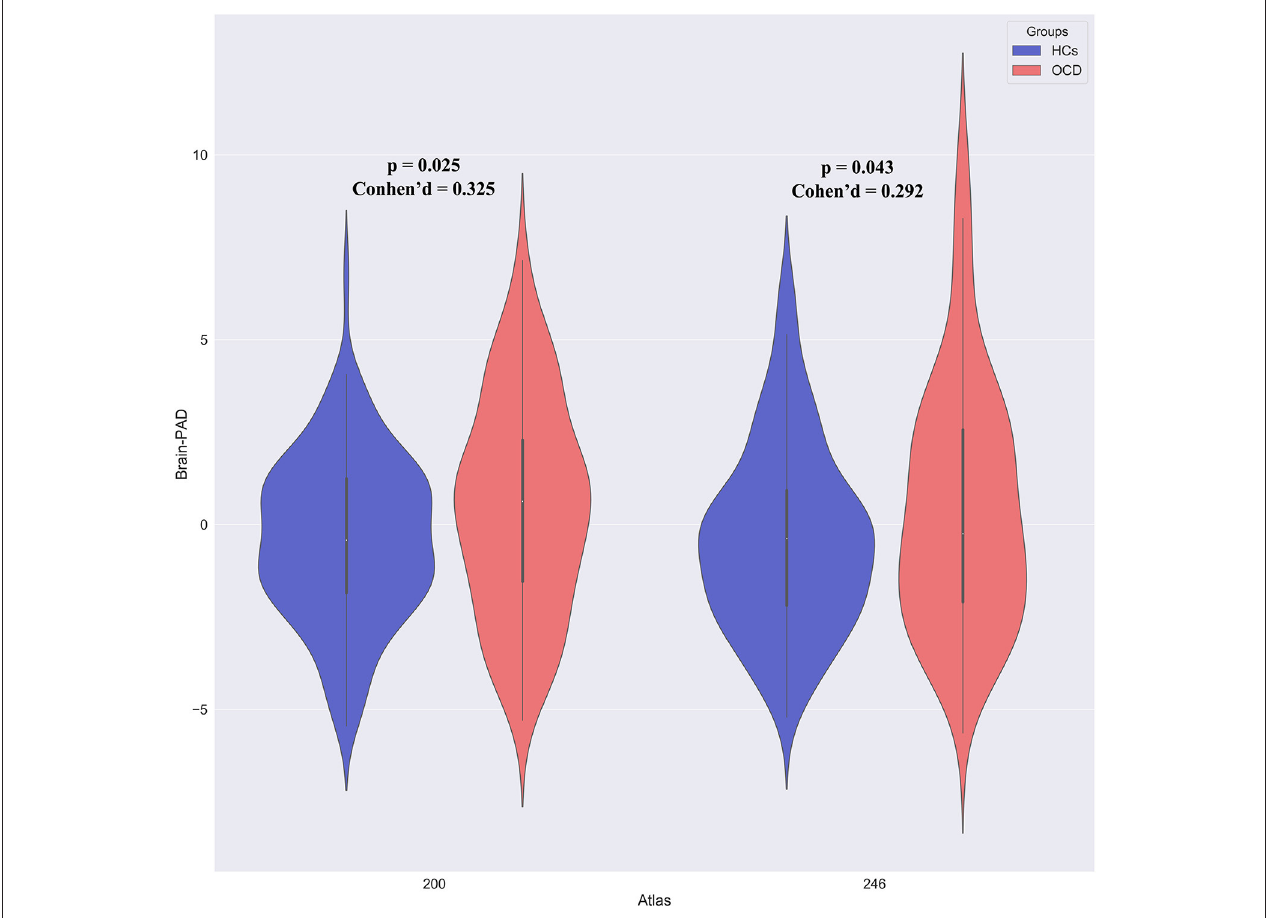
FIGURE 3 | Aberrance of brain-PAD scores in patients with